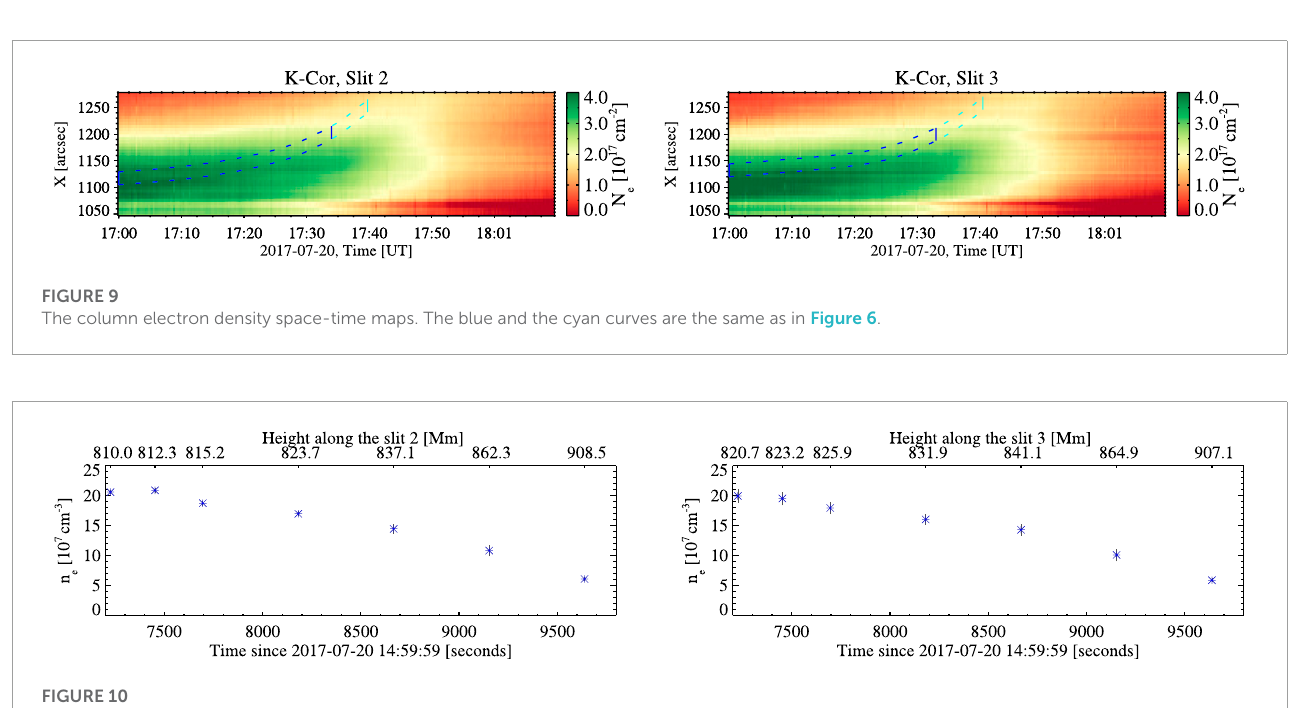
The excess column electron density N be estimated by taking the ratio of the excess observed pB (pB to the polarized brightness of a single electron (pB lie on the plane of sky (POS) (Colaninno and Vourlidas 2009).